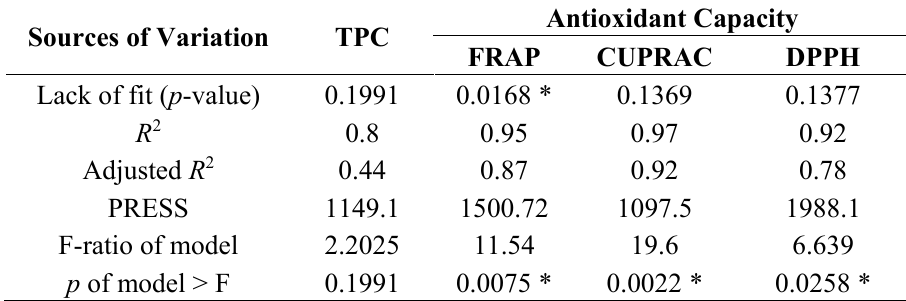
phenolic compounds; FRAP, ferric reducing antioxidant power; CUPRAC, cupric reducing antioxidant capacity; PRESS, predicted residual sum of squares. Sources of Variation